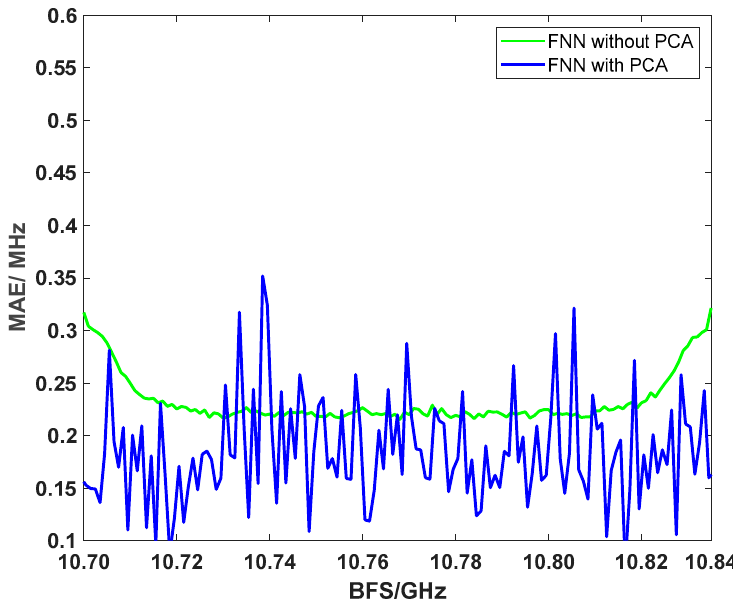
Figure 6. Comparison between FNN with PCA and FNN without PCA. FNN with PCA is the proposed method and other FNN is taken from [13]. Table 3. Details of the comparison between FNN with PCA and FNN without PCA.